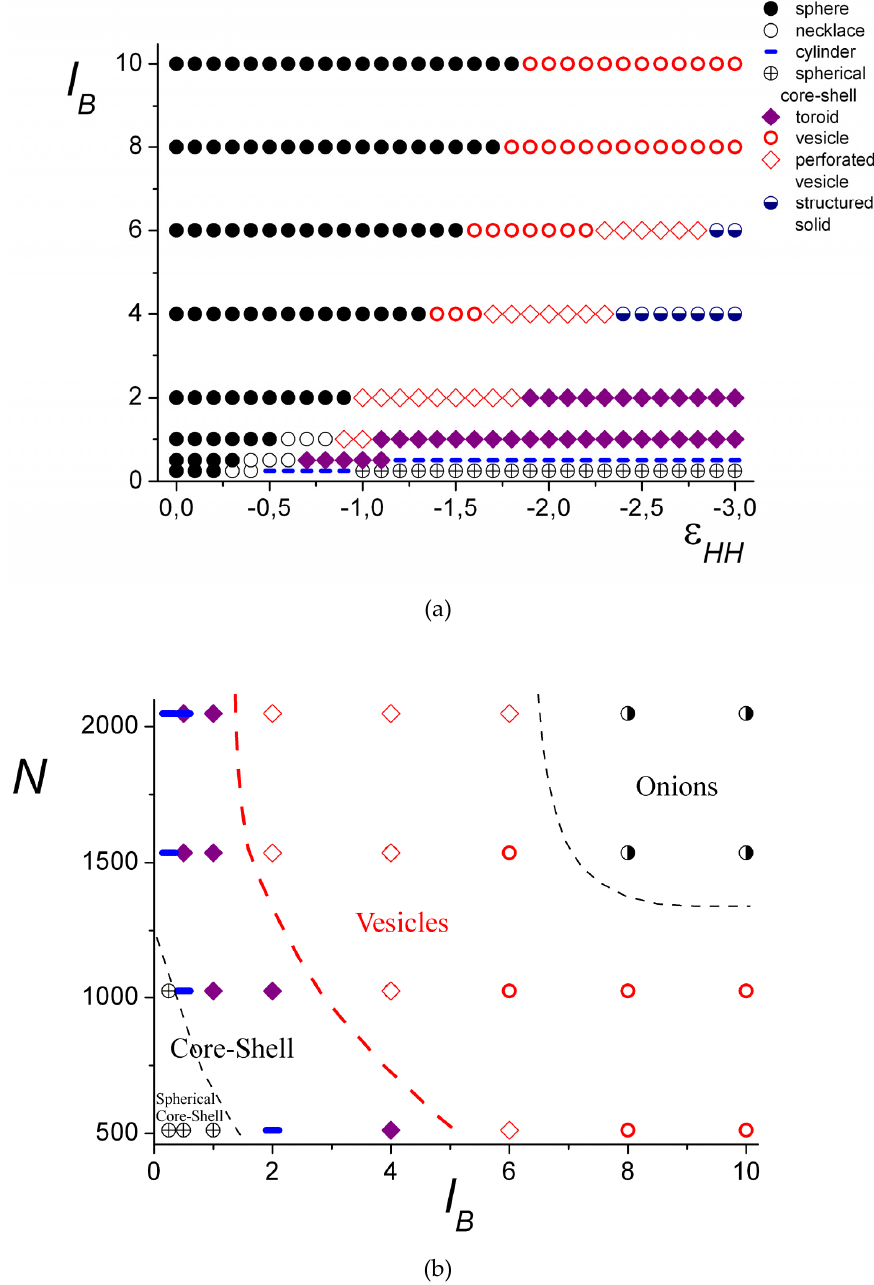
Figure 7. The morphological diagrams “solvent quality vs. Bjerrum length,” N = 1024 ( a ) and “Bjerrum length vs. chain length,” ε HH = − 2.0 ( b